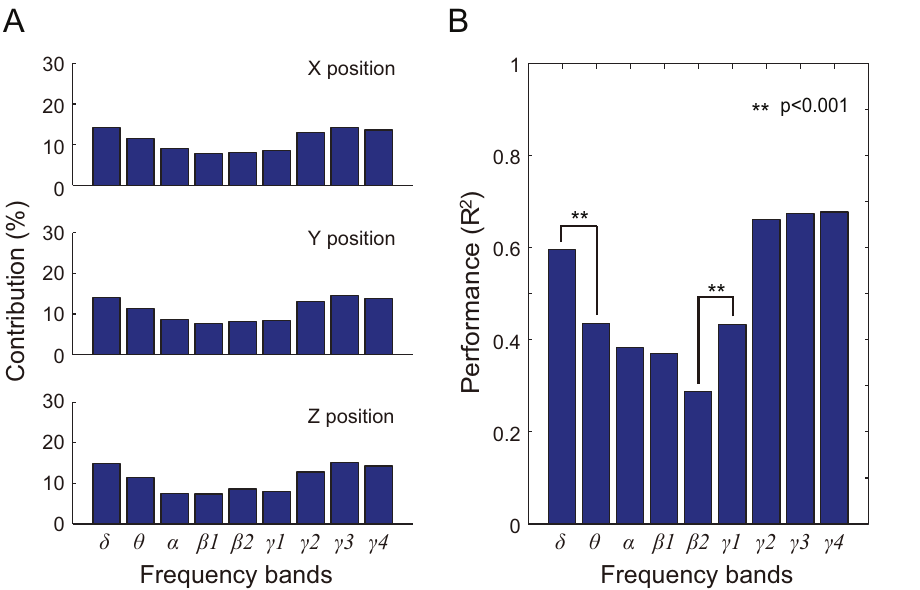
Figure 8. Contribution and performance of specific frequency bands for monkey B. A) Each bar represents the weight of each frequency band in the PLS model. From top to bottom, the graphs depict contributions to X, Y, and Z positioning, respectively. B) Prediction results using each frequency band. We performed a two-way ANOVA with effects positioning and frequency bands. Each bar represents the mean R 2 value of X, Y, and Z positioning when comparing observed and predicted hand trajectories. Significant differences between mean R 2 values are denoted with * (p , 0.001).